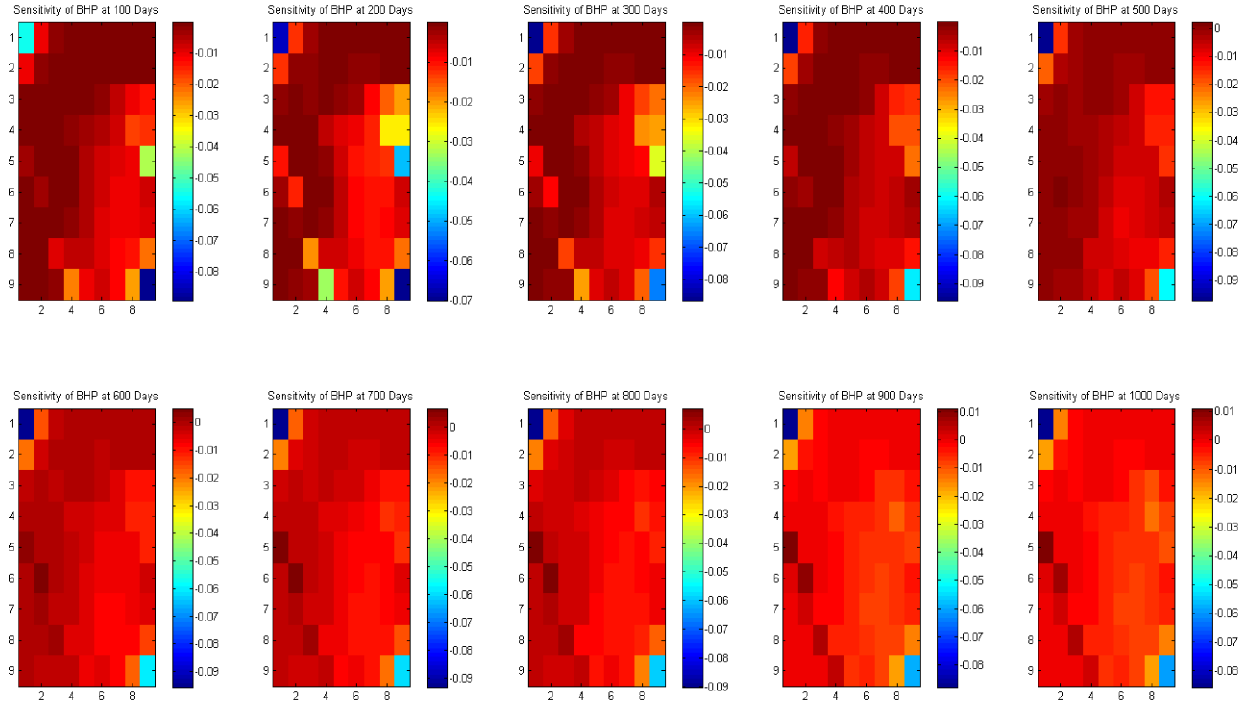
Figure 9—Sensitivity of BHP.